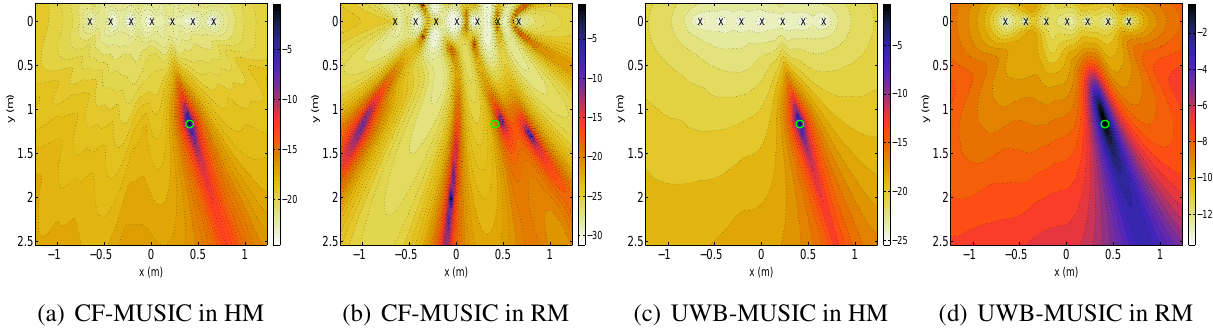
Figure 11. Images (in dB scale) obtained both in homogeneous (HM) and random media (RM) by CF-MUSIC and